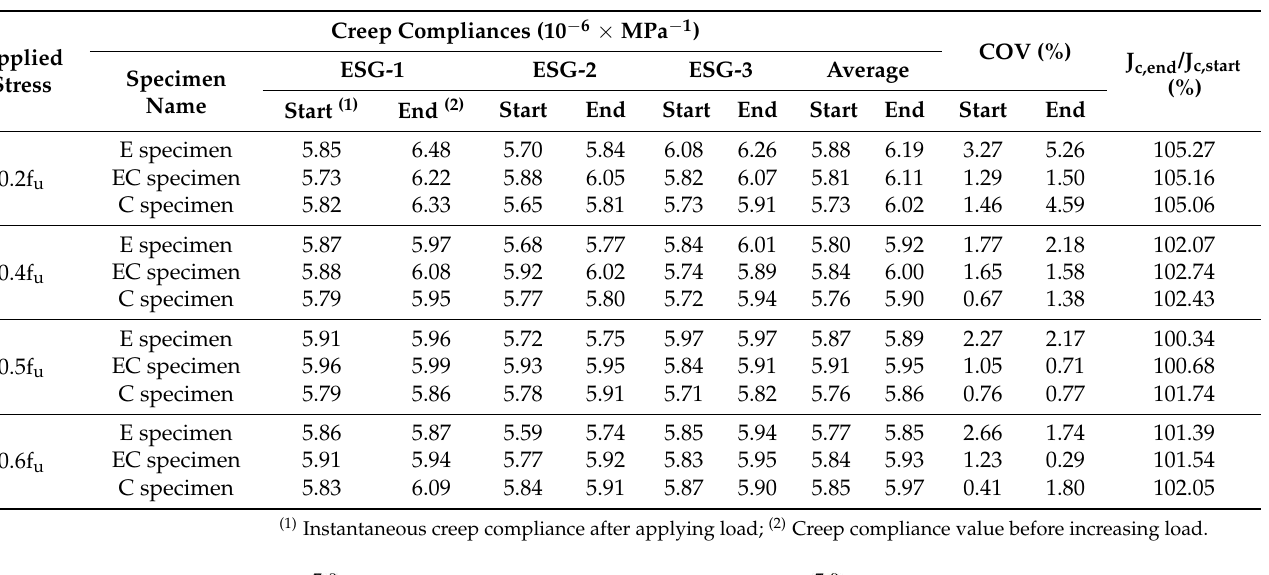
Table 4. Creep compliance of the FRP strip.